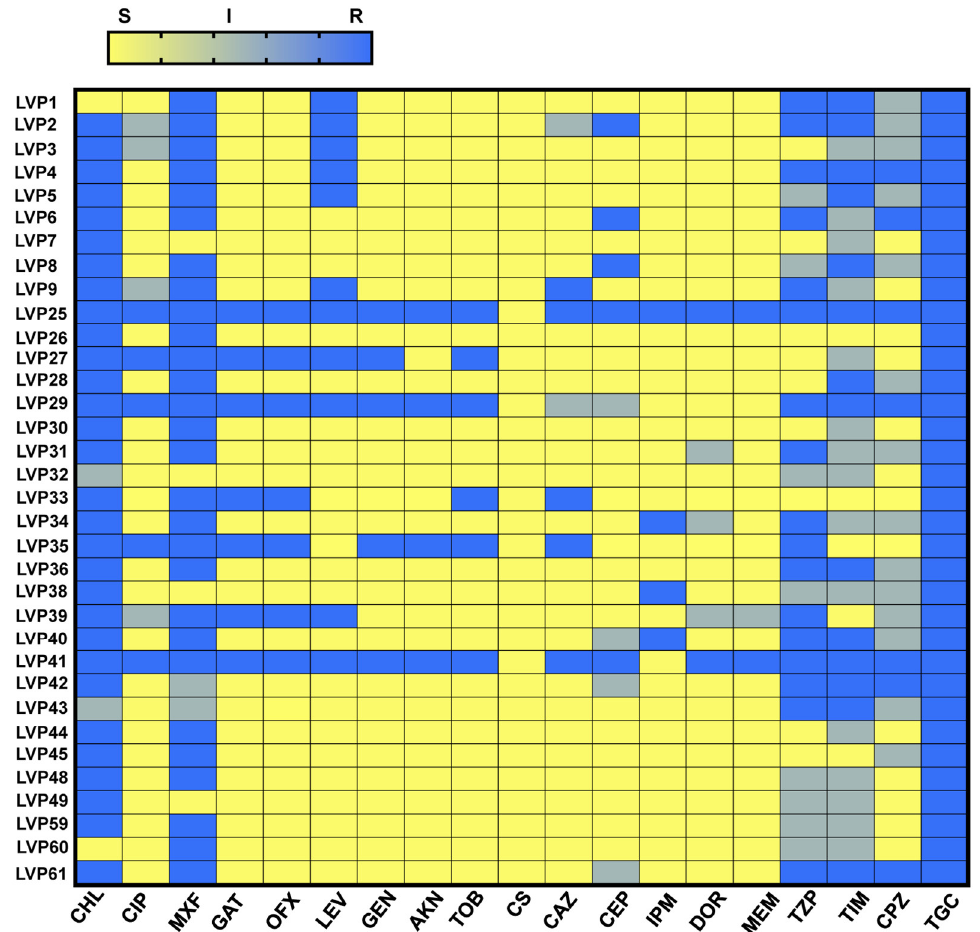
Figure 1. Heat map representing antibiotic resistance of ocular clinical isolates of P. aeruginosa . The antibiotic susceptibility for thirty-four clinical isolates were tested by minimum inhibitory concentration method against mentioned antibiotics and a heat map was constructed to compare the antibiotic resistance among the isolates. S denotes susceptible, I denotes intermediate, and R denoted resistance to antibiotics.